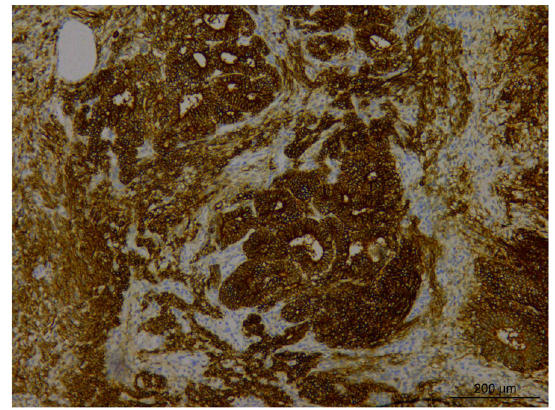
Fig. 6 Immunohistochemical staining visualized at